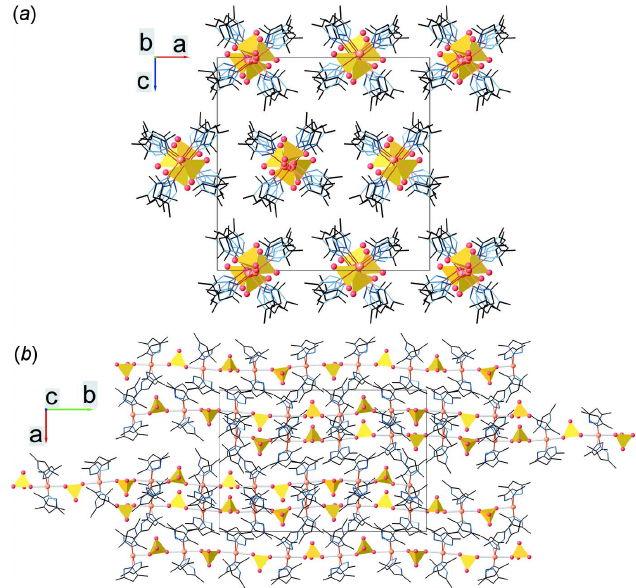
Figure 5 Crystal packing of the title compound viewed along the ( a ) b - and ( b ) c - axis directions: sulfate ligands are in a polyhedral representation with red spherical oxygen atoms, copper atoms are represented as orange spheres, while pyrazole rings atoms are depicted as wireframes. Hydrogen atoms are omitted for